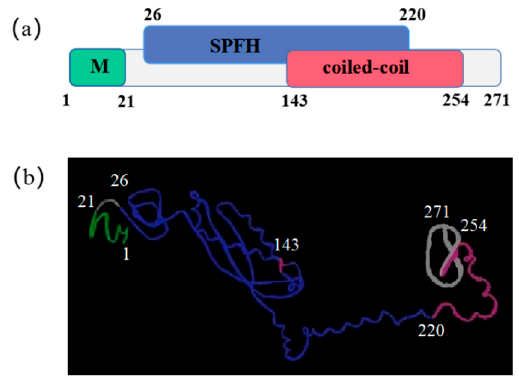
Figure 4. Putative domain structure and 3-D structure of Ob- PHB. ( a ) Green indicates the transmem- brane domain (1–21 aa), blue indicates the putative PHB domain (26–220 aa), and red is the coiled-coil domain (143–254 aa). ( b ) Predicted 3-D structure of PHB.